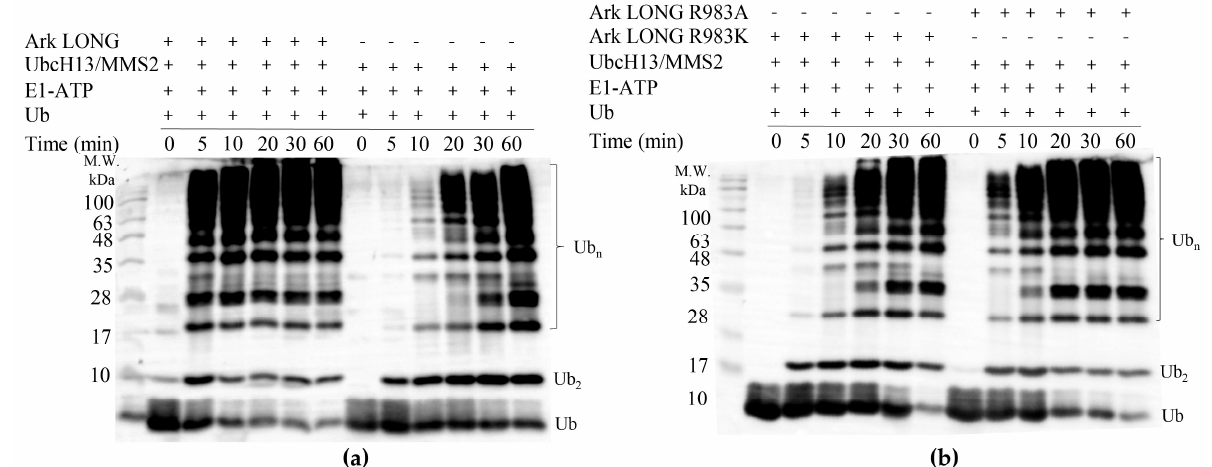
Figure 7. ( a ) In vitro ubiquitylation assays using UbcH13/MMS2 complex in the presence and absence of Ark LONG. ( b ) In vitro ubiquitylation assays using UbcH13/MMS2 complex in the presence of Ark LONG R983A or R983K.